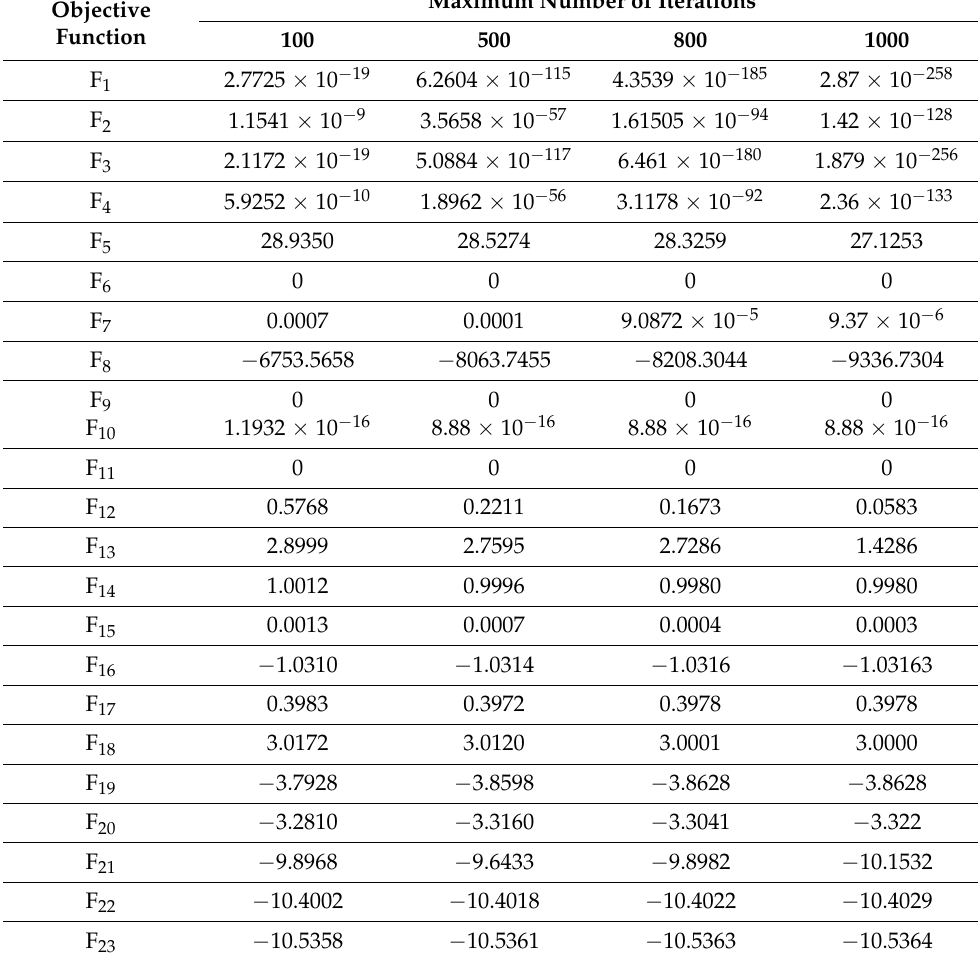
Table 7. Sensitivity analysis of the POA to T